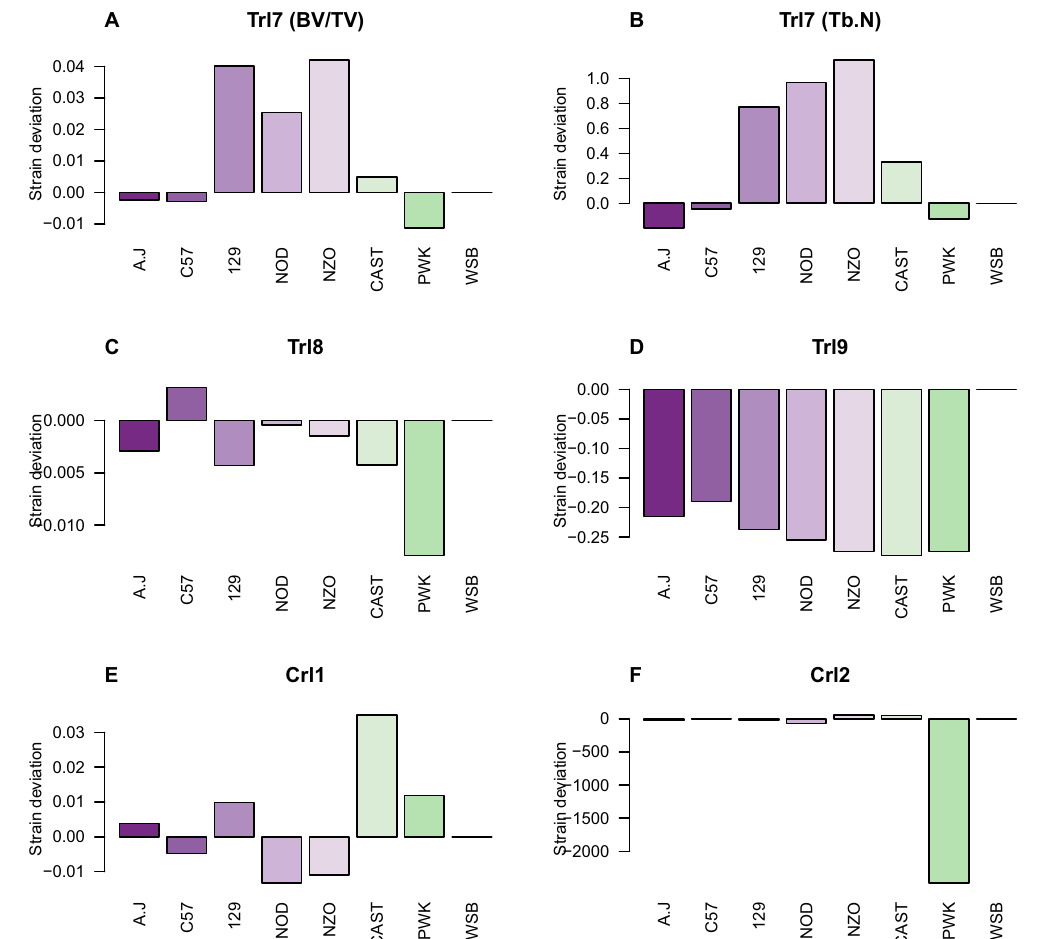
Figure 2. Ancestral effects relative to WSB. The y-axis represents the strain deviation relative to WSB; the x-axis represents the different strains of the eight CC founders. (A – F) Trl7 to Trl9 , Crl1 , and Crl2 ,